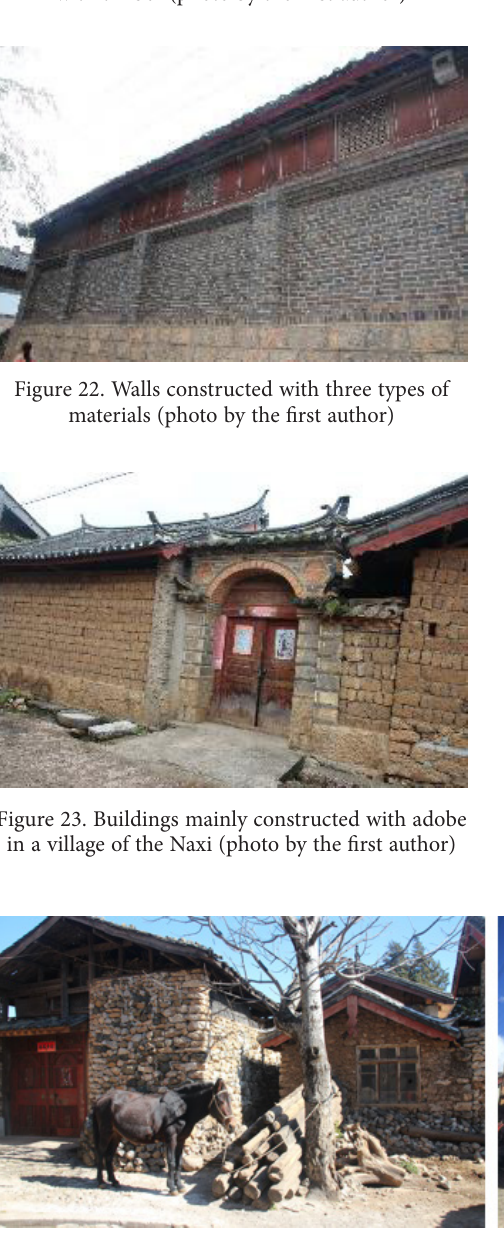
Figure 21. Buildings with the facade constructed with timber (photo by the first author)